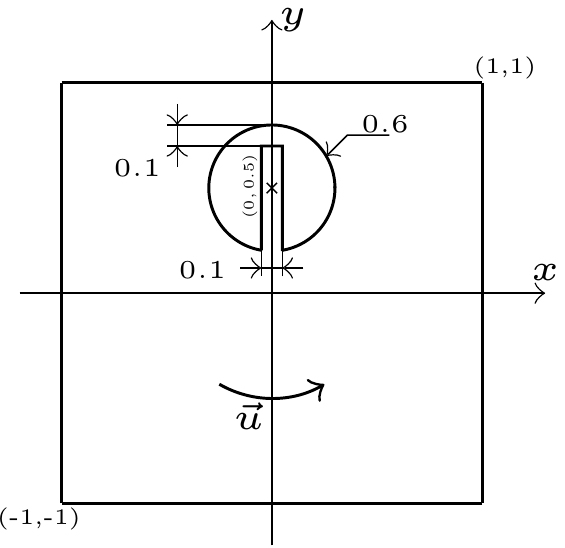
Figure 15. Setup for the rotation of Zalesak’s disk (all measurements in metres).